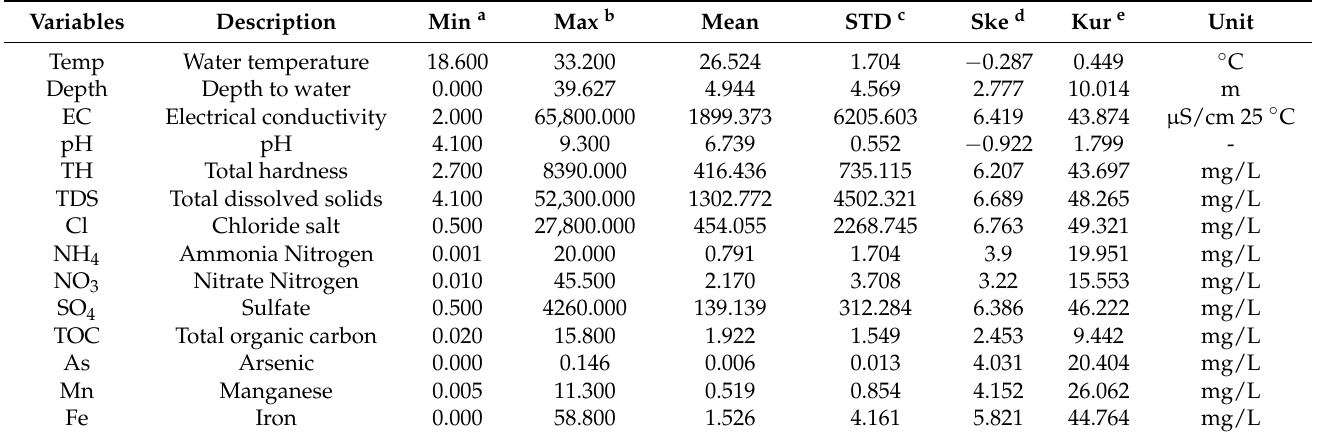
Figure 2. The locations of 453 observation wells in ten groundwater basins in Taiwan. Table 1. Statistical summary of physicochemical parameters.